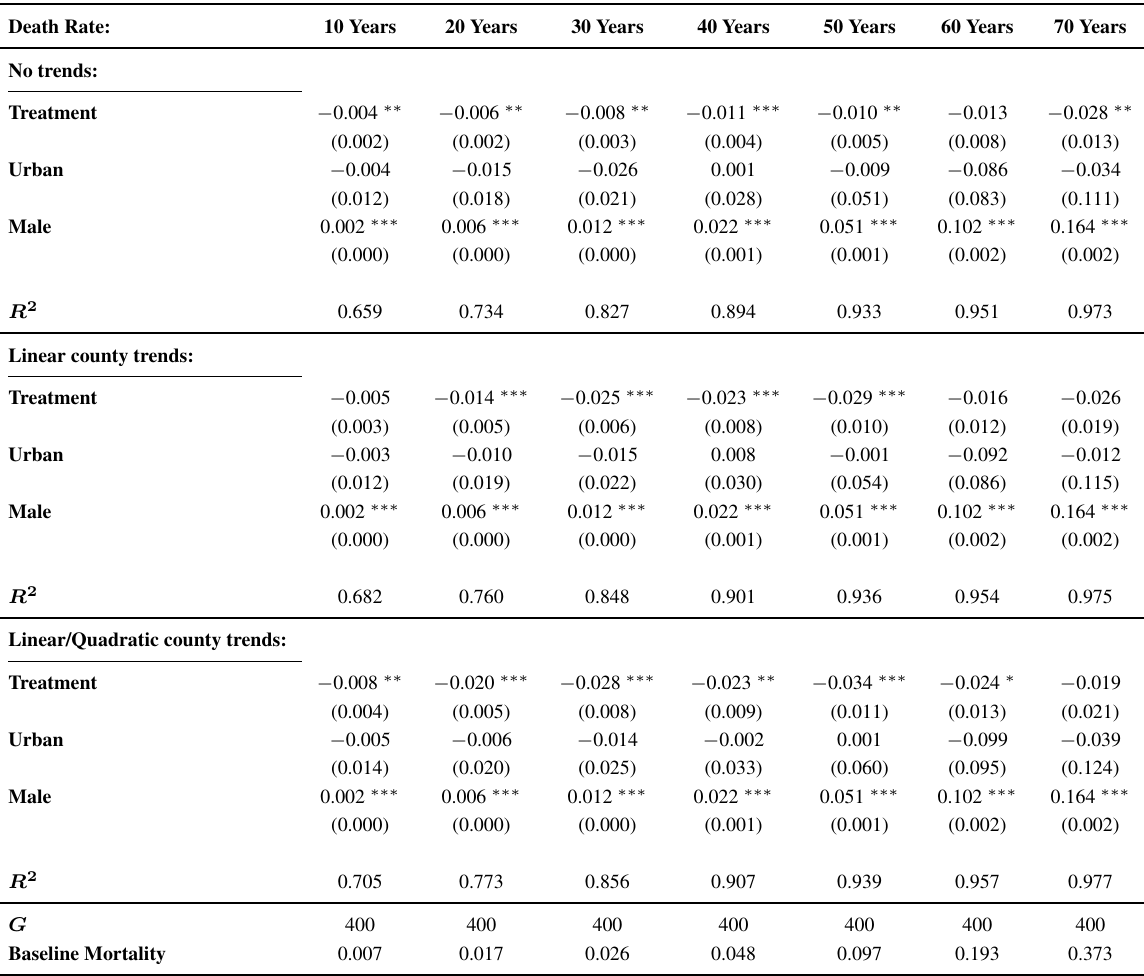
Dependent variable: average number of deaths within x-years. Additional controls: cohort dummies, county dummies. Standard errors (in parentheses) are robust against heteroscedasticity and clustered on the cohort state level. G corresponds to the number of cells defined by gender, cohort and county of birth. All regressions are calculated using weights. Weights are given by the number of observations in each cell. ∗ signifies that the relationship between the point estimate and standard error is above the level required for statistical significance at the 10% level in a linear regression model, ∗∗ at the 5% level and ∗∗∗ at the 1%